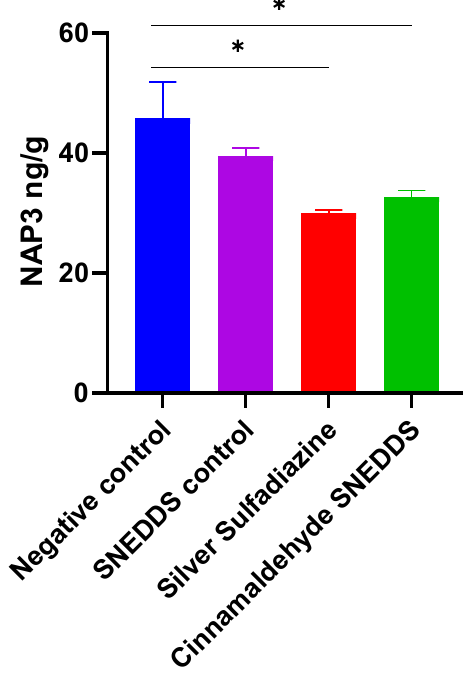
Figure 7. Effect of cinnamaldehyde on the inflammatory marker in skin burn rat model. Values are denoted as mean ± SEM, N = 5 rats per group. Statistical significance was found using one-way ANOVA, followed by a post hoc test in GraphPad Prism 8.0.2. NAP3: Neutrophil-activating protein 3. * p < 0.05 vs. negative control using Tukey’s multi-group comparisons.